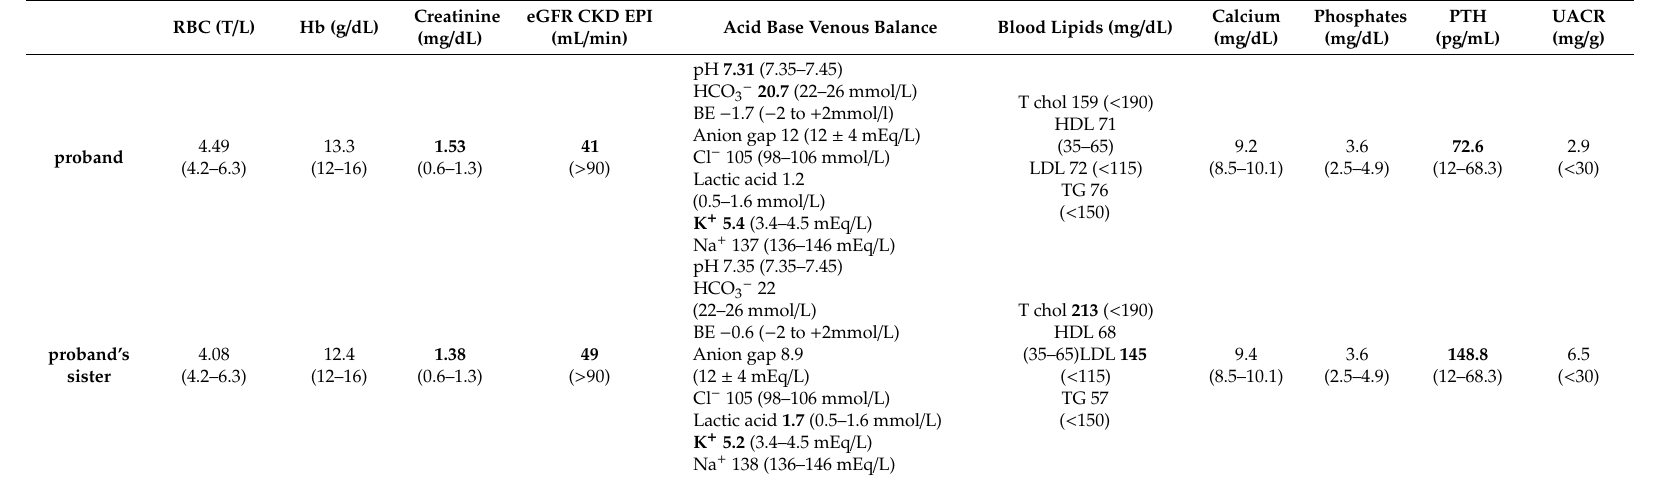
Table 1. Laboratory results of the proband and her sister.